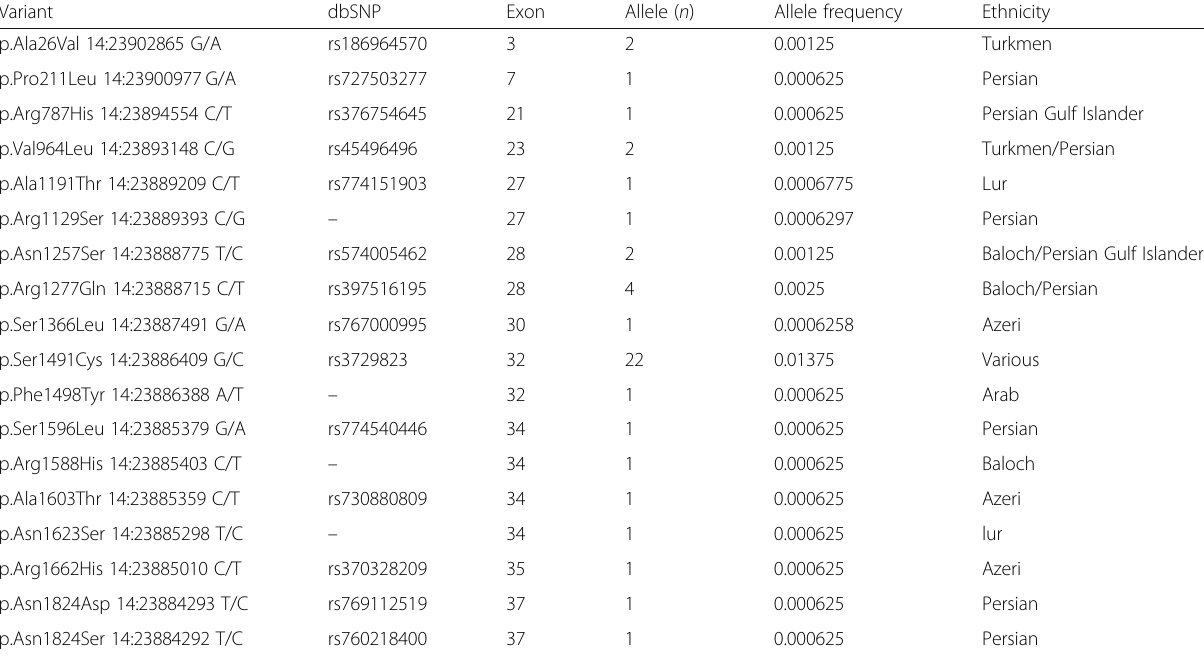
Table 1 Characterization of MYH7 missense variants along with exon location, allele frequencies in Iranian ethnic groups and the